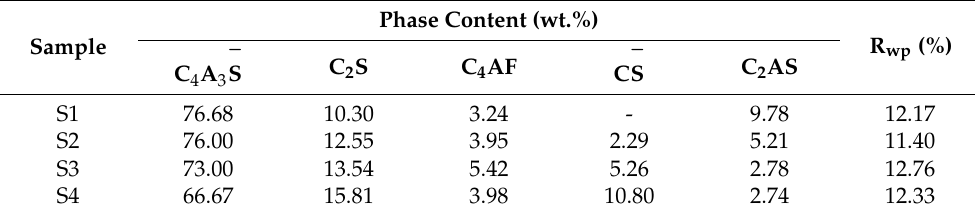
Table 5. Contents of cement clinker minerals